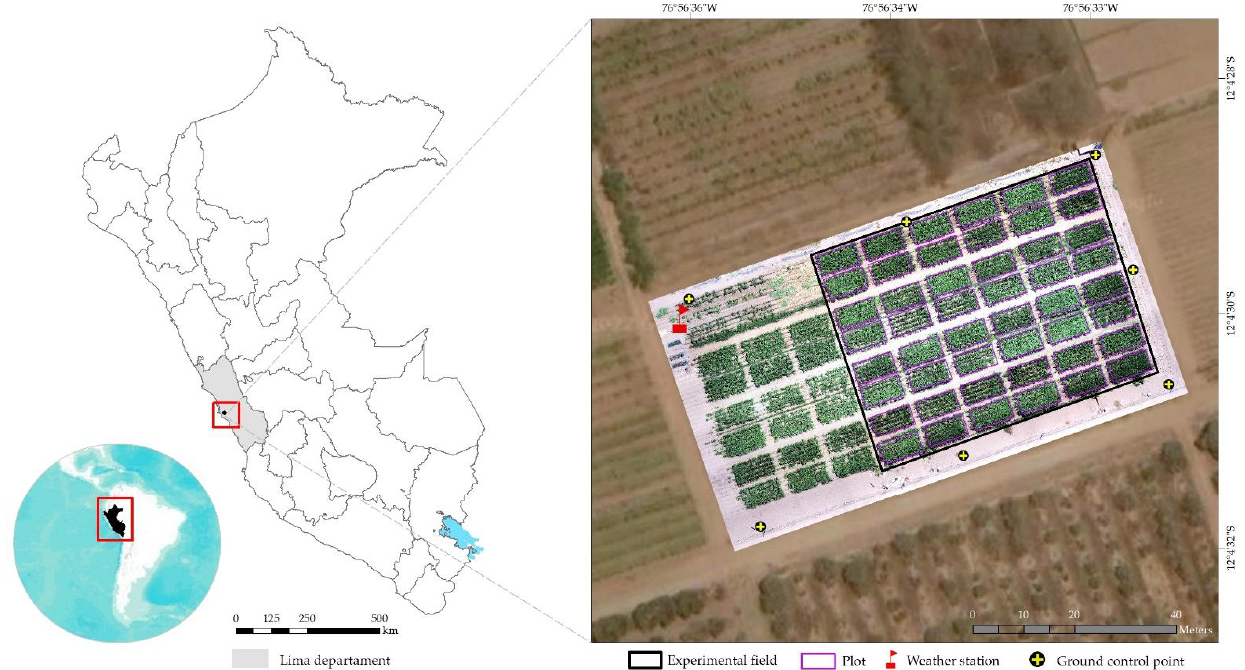
Figure 1. Location of the study area the La Molina Experimental Center in Lima (Peru).